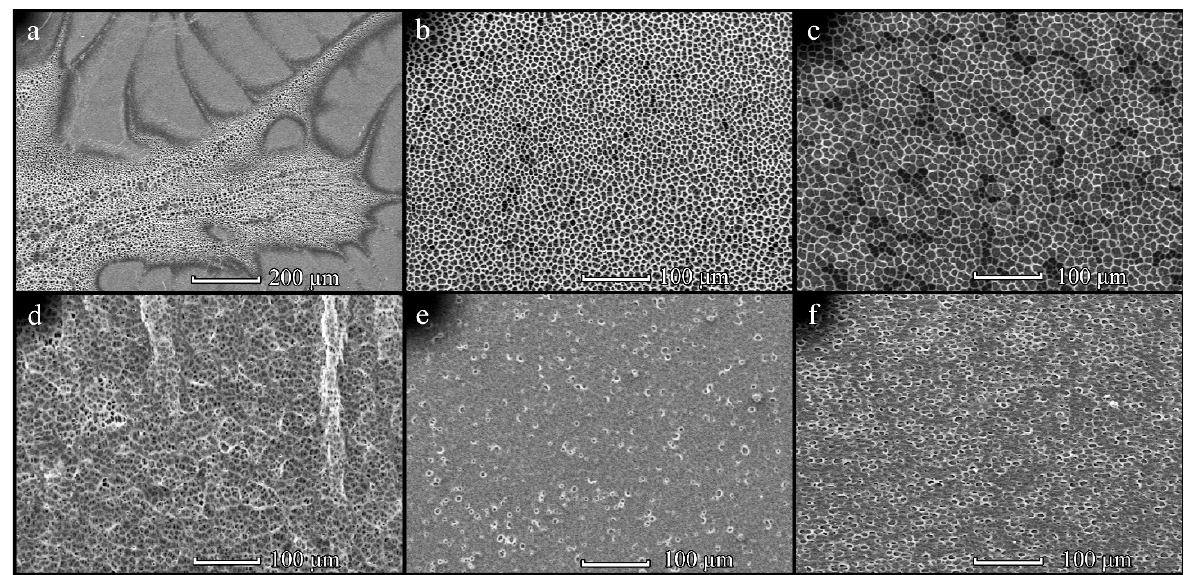
Figure 4. SEM-images of the PHB- co -HV(9%) films obtained from solution with concentrations of 10 ( a , d ), 20 ( b , e ) and 40 ( c , f ) mg/mL at L = 1 cm. The solution volume is 150 ( a – c ) and 450 ( d – f ) μ L. Based on the obtained histograms, pore sizes of PHB- co -HV(9%) remained unchanged at a distance of 1 cm (Figure S4, Supplementary Materials), however, elevation of the polymer volume at 3 cm from 150 μ L to 300 μ L resulted in over a 3-fold increase in the average pore size with an average pore area reaching 156.6 ± 28.6 μ m 2 ( p < 0.05, at 3 cm, 40 mg/mL, 300 μ L).